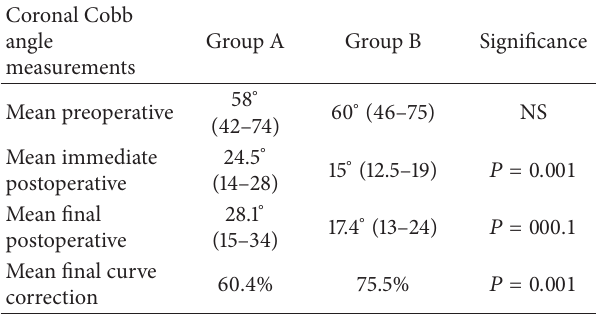
Table 1: Coronal preoperative, immediate, and final postoperative Cobb angle measurements and final correction in both